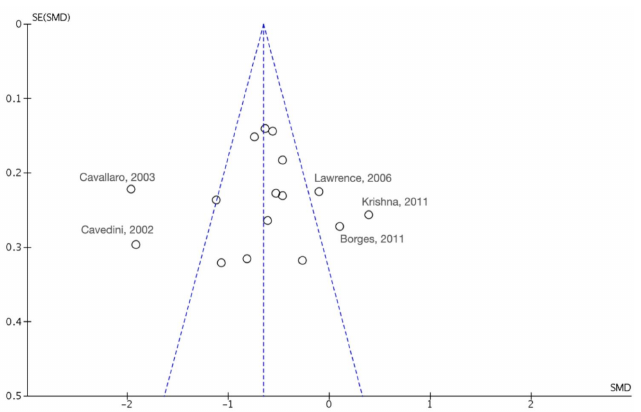
Figure 3. Funnel plot of effect size against standard error with identification of potential